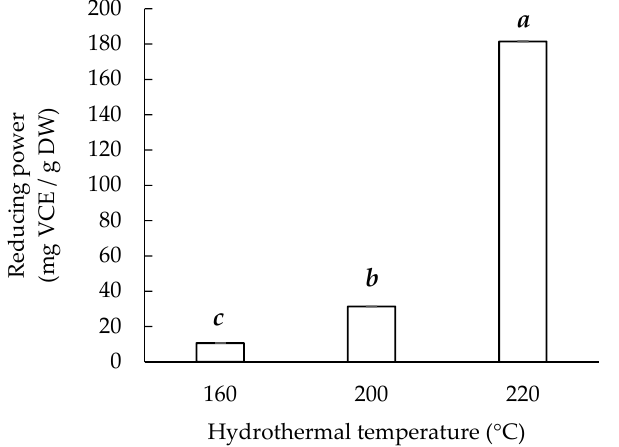
Figure 6. Hydrothermal extraction temperature and ferric reducing power of sericin extracts. Means with the same lowercase letters are not significantly different, per LSD test results.